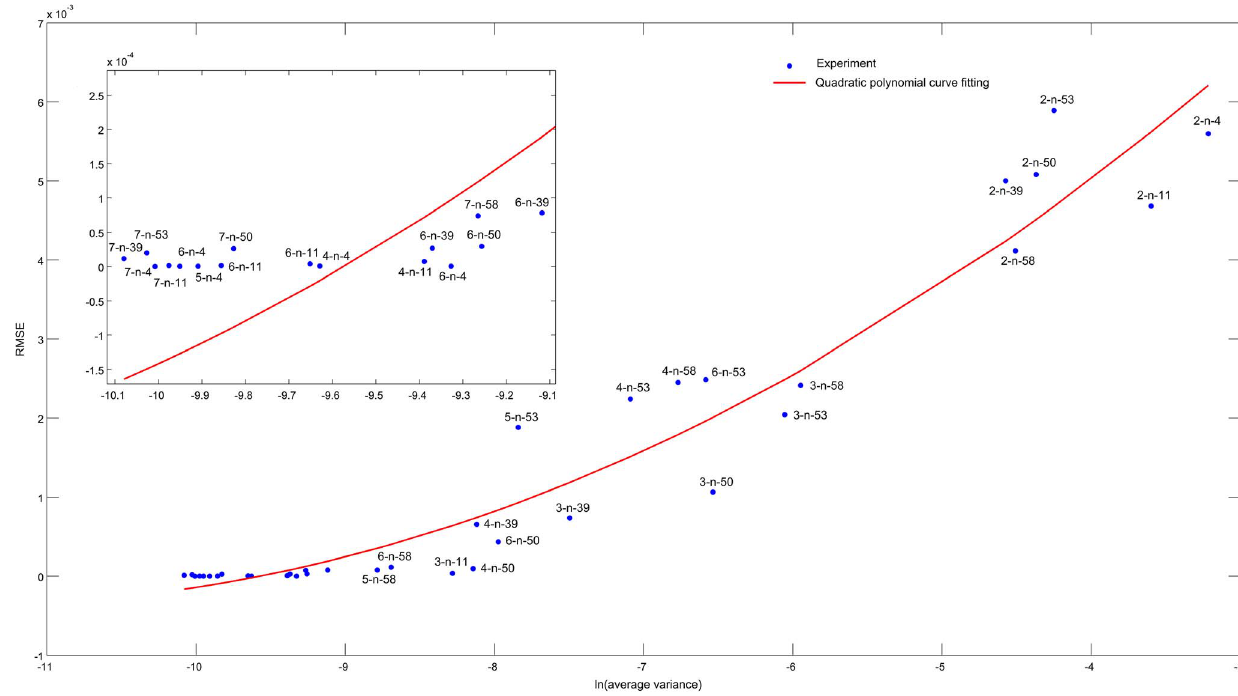
Figure 8. Relationship between the average variance and RMSE. Each point represents an experiment for a benchmark network under a specific number of perturbations. For example, 2-n-53 means the experiment for n-53 network under 2 perturbations. The x-coordinate indicates the natural logarithm of the average variance for all elements in the refined transition matrix, while the y-coordinate indicates the RMSE values of the refined transition matrix. The RMSE values range from 1 : 6 | 10 { 7 to 5 : 9 | 10 { 3 and the average variance varies from 4 : 2 | 10 5 { to 4 : 0 | 10 2 { .